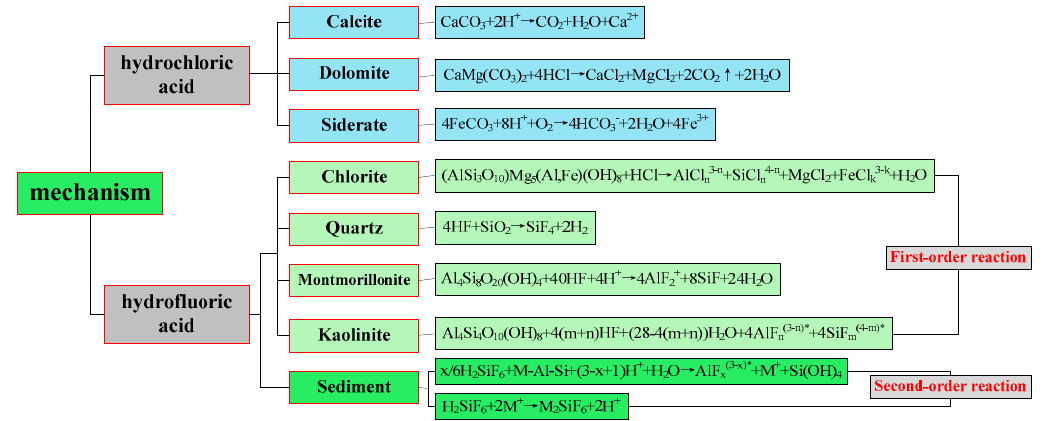
Figure 2. Reaction mechanism of minerals and acids.